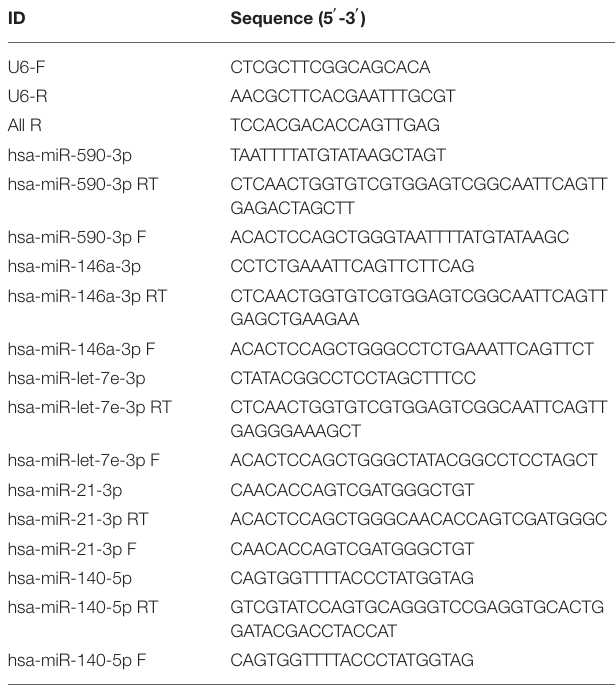
TABLE 1 | Primers used in the present